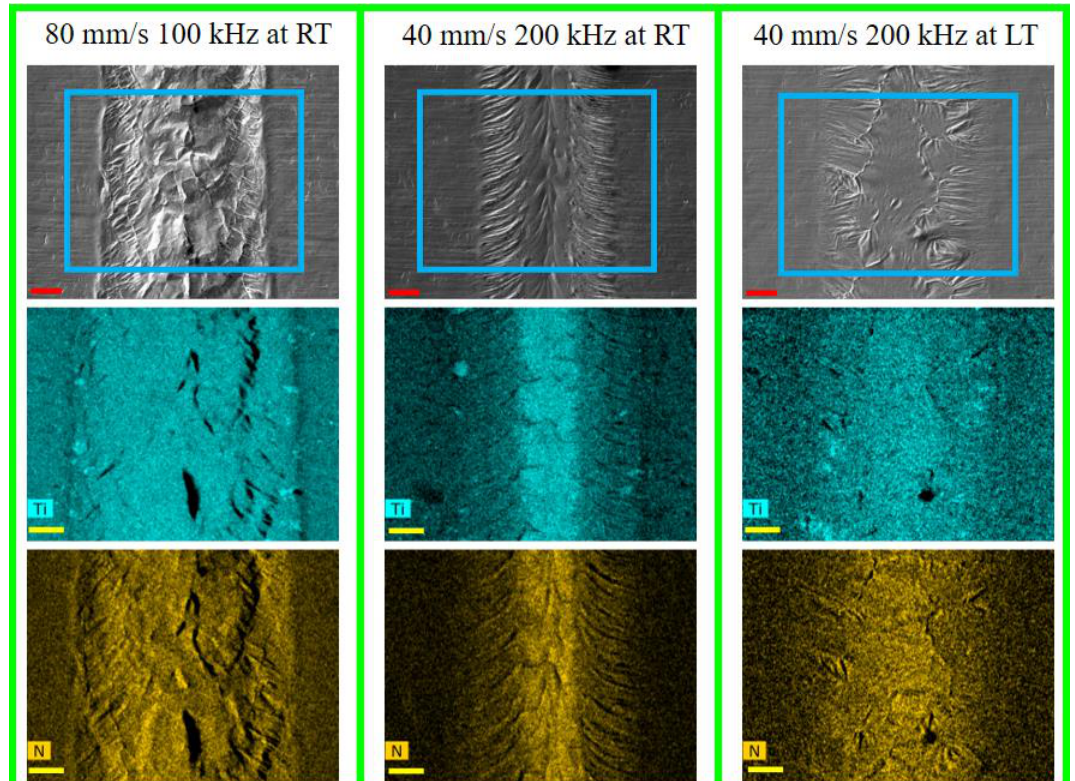
Figure 2. The SEM images and EDX mapping results on the surface of NiTi alloy after single laser scanning (red scale bar: 40 µm and yellow: 40 μm). Laser processing parameters (scanning velocity, laser repetition rate, temperature) were given in the first row of the table. RT stays for the room temperature, LT-for process with liquid nitrogen temperature.